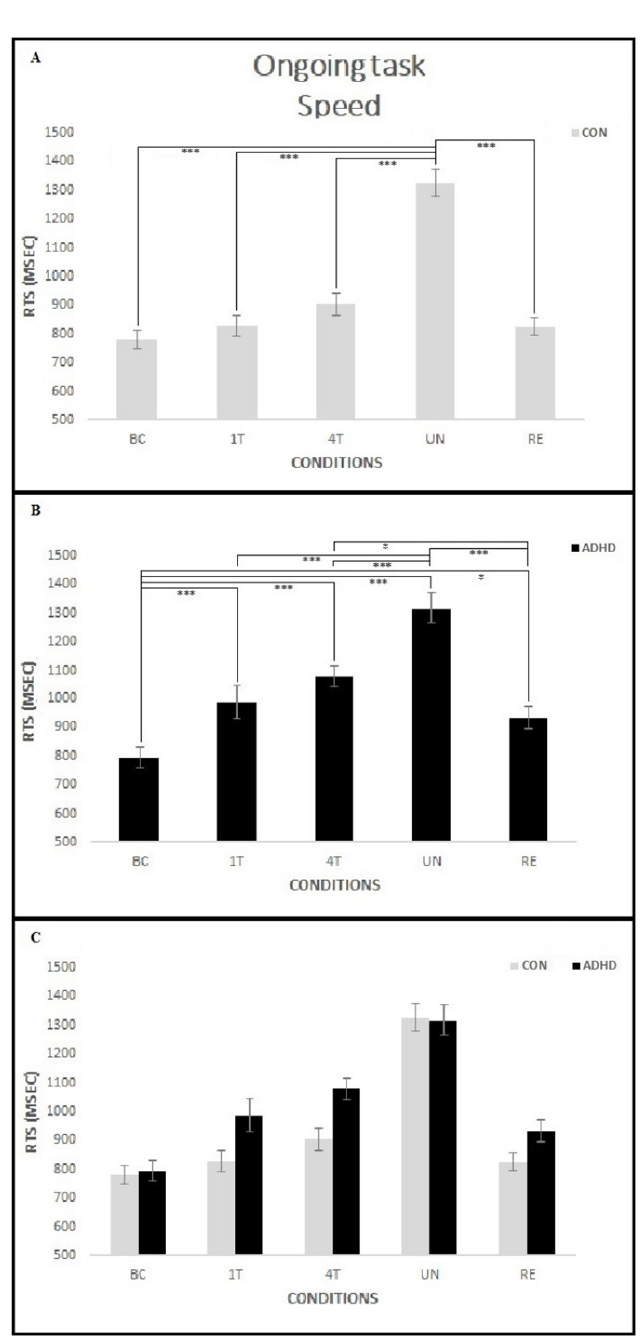
Figure 7. Ongoing task speed for each condition in the two groups. Within-groups differences emerged in the mean response RTs (see A , B ), but no significant differences occurred between groups ( C ). In the CON group ( A ), no difference emerged between the mean response RTs in the BC and almost all PM conditions (1T, 4T, RE), with the exception of the UN, in which they were slower than all other conditions. In the ADHD group ( B ), participants were slower in all PM conditions compared to BC; moreover, as in the CON group, on the UN they were slower than all other conditions. Finally, the mean response RTs on the 4T was slower than the RE condition. Asterisks mark significant differences: * p < 0.05, *** p <